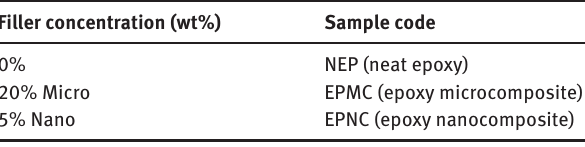
Table 1: Prepared epoxy composite samples. Filler concentration (wt%)